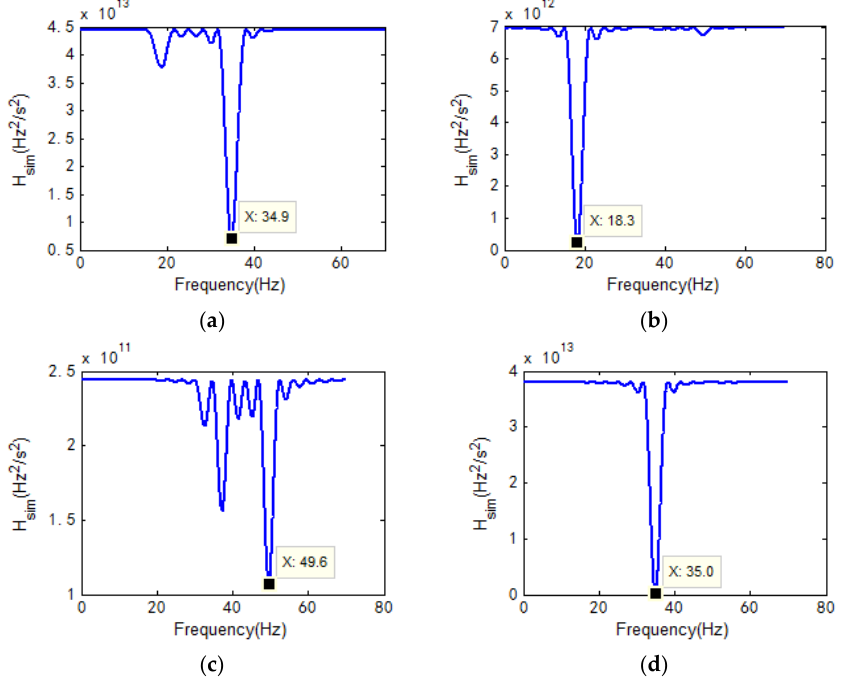
Figure 6. Objective function curve. ( a ) The first iteration; ( b ) the second iteration; ( c ) the third iteration; ( d ) re-estimate of the first component.